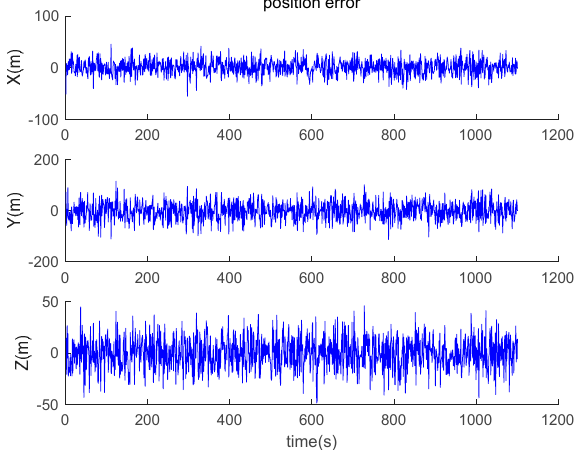
Figure 13. The variation of tight coupling data: ( a ) satellite pseudo-range variation; ( b ) satellite Doppler shift.